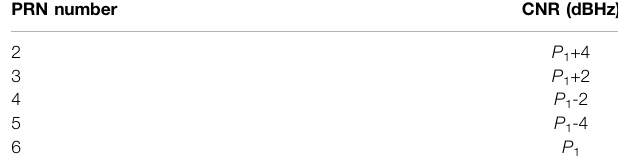
TABLE 4 | Carrier-to-noise ratio